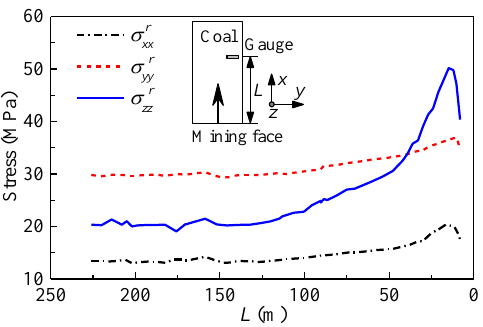
Figure 15. Variations of three normal stresses in the roof with distance from the mining face.